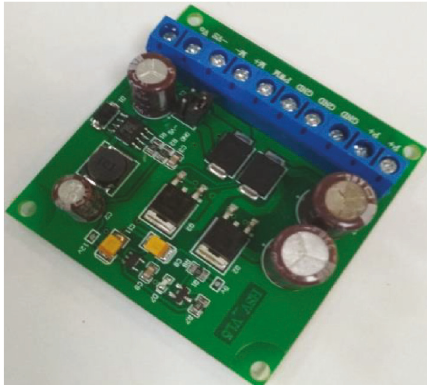
Figure 13: Electronic control board.